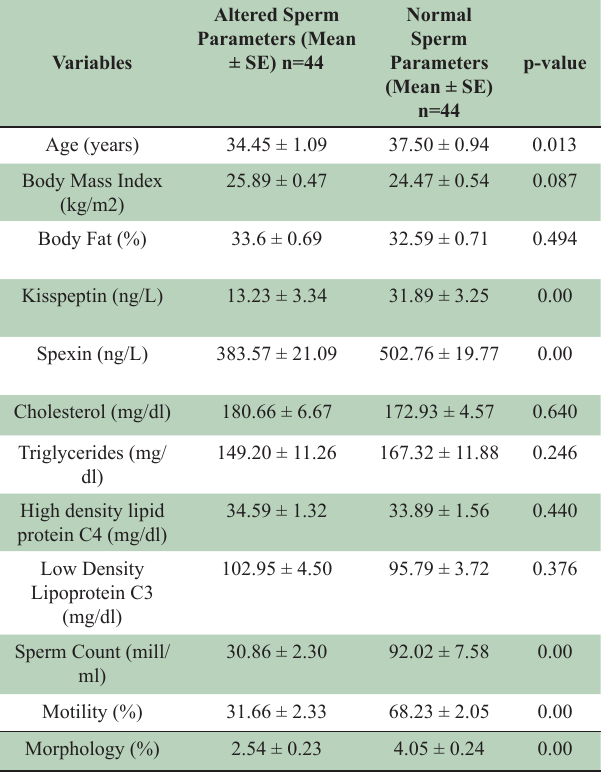
Figure-II: Scatter plot and correlation analysis between KP and SPX in subjects with normal and altered sperm parameters. Table-II: Correlation of spexin and kisspeptin with lipid